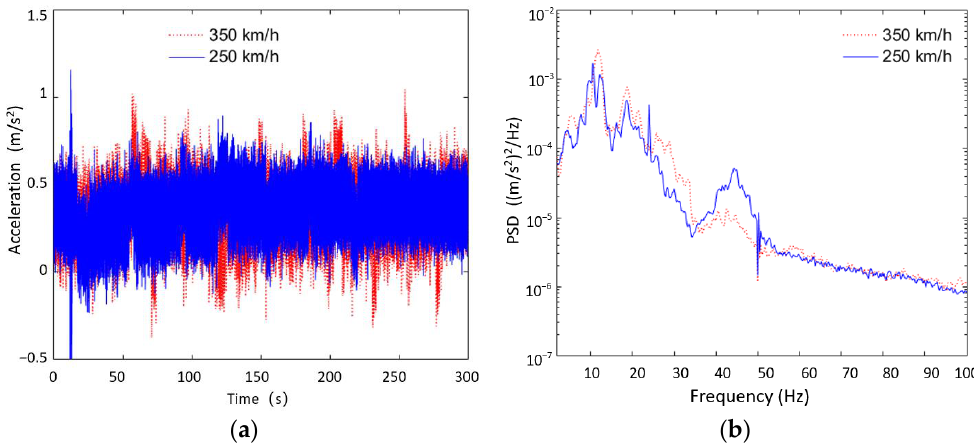
Figure 3. Z -direction acceleration measured at the seat pan. ( a ) Signals in time domain; ( b ) power spectral density.